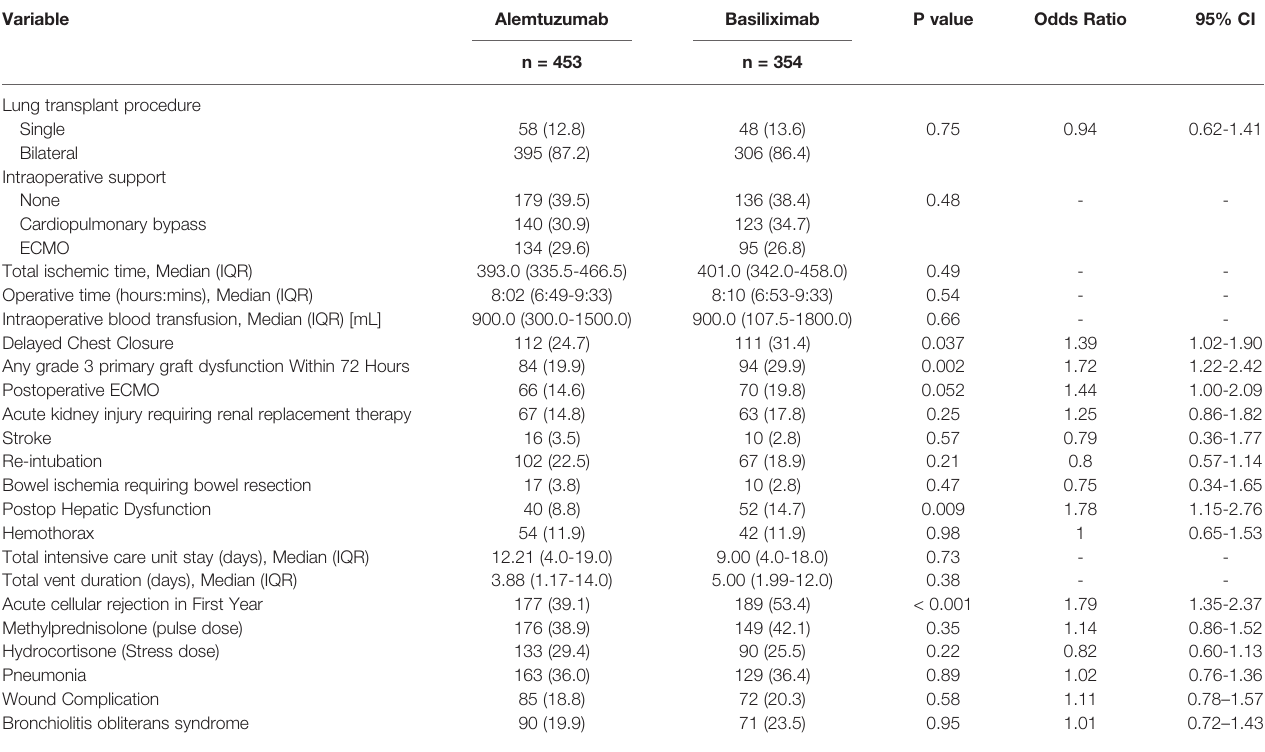
TABLE 2 | Operative and post-operative